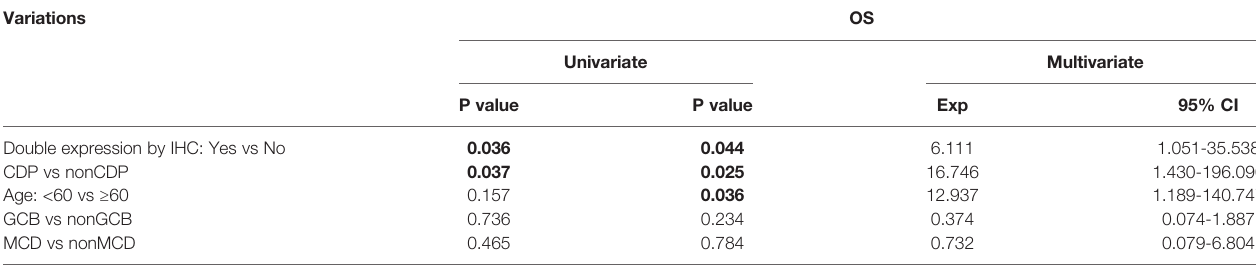
TABLE 2 | Univariate and Multivariate analysis of risk factors associated with patients ’ survival. Variations OS